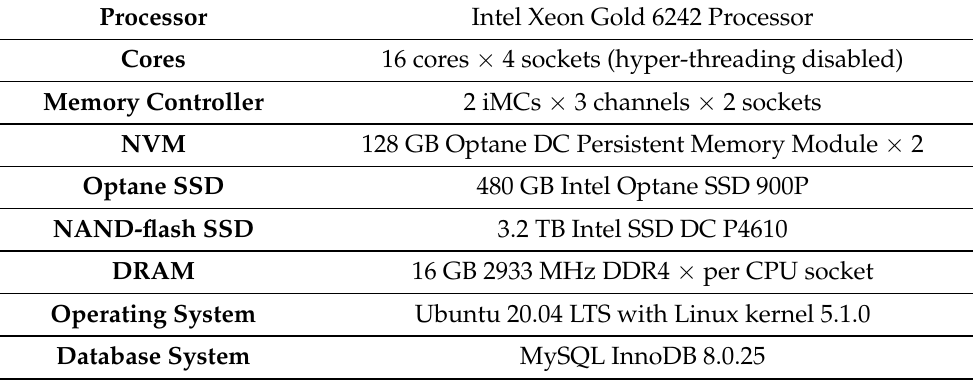
Table 1. Evaluation platform specifications.